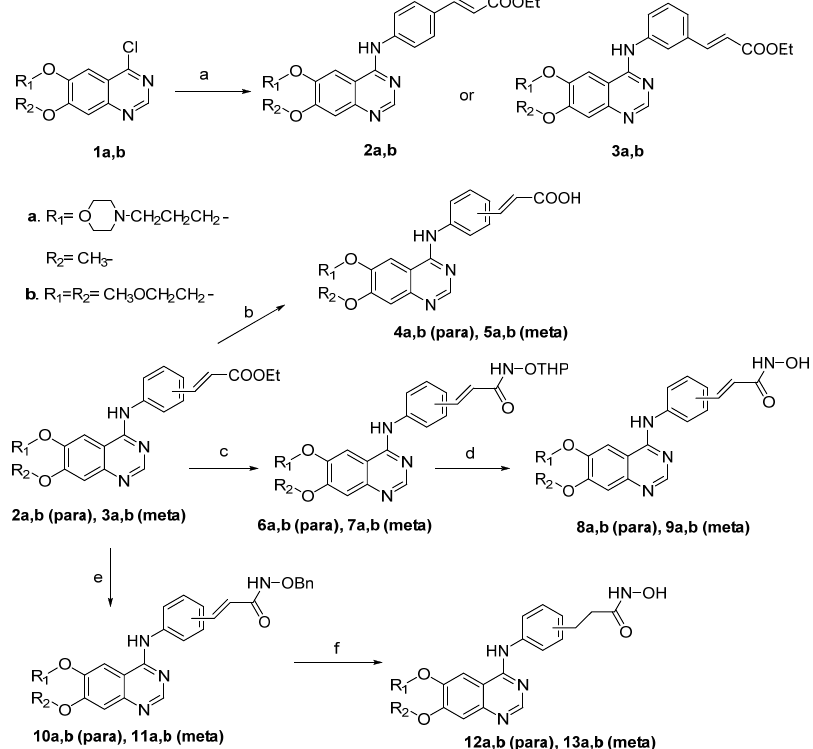
Scheme 1. Synthesis of dual-acting HDAC-RTK